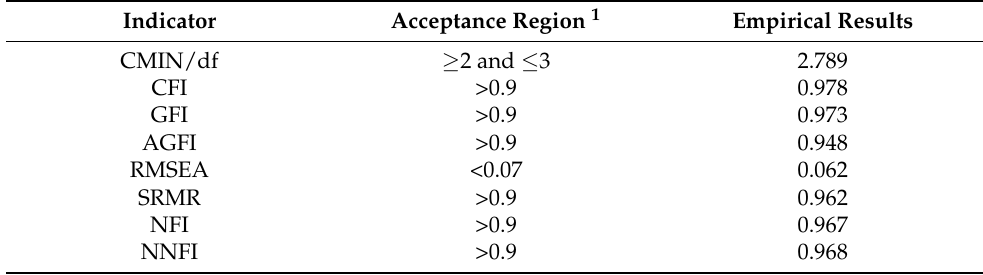
Table 6. Results of confirmatory factor analysis.